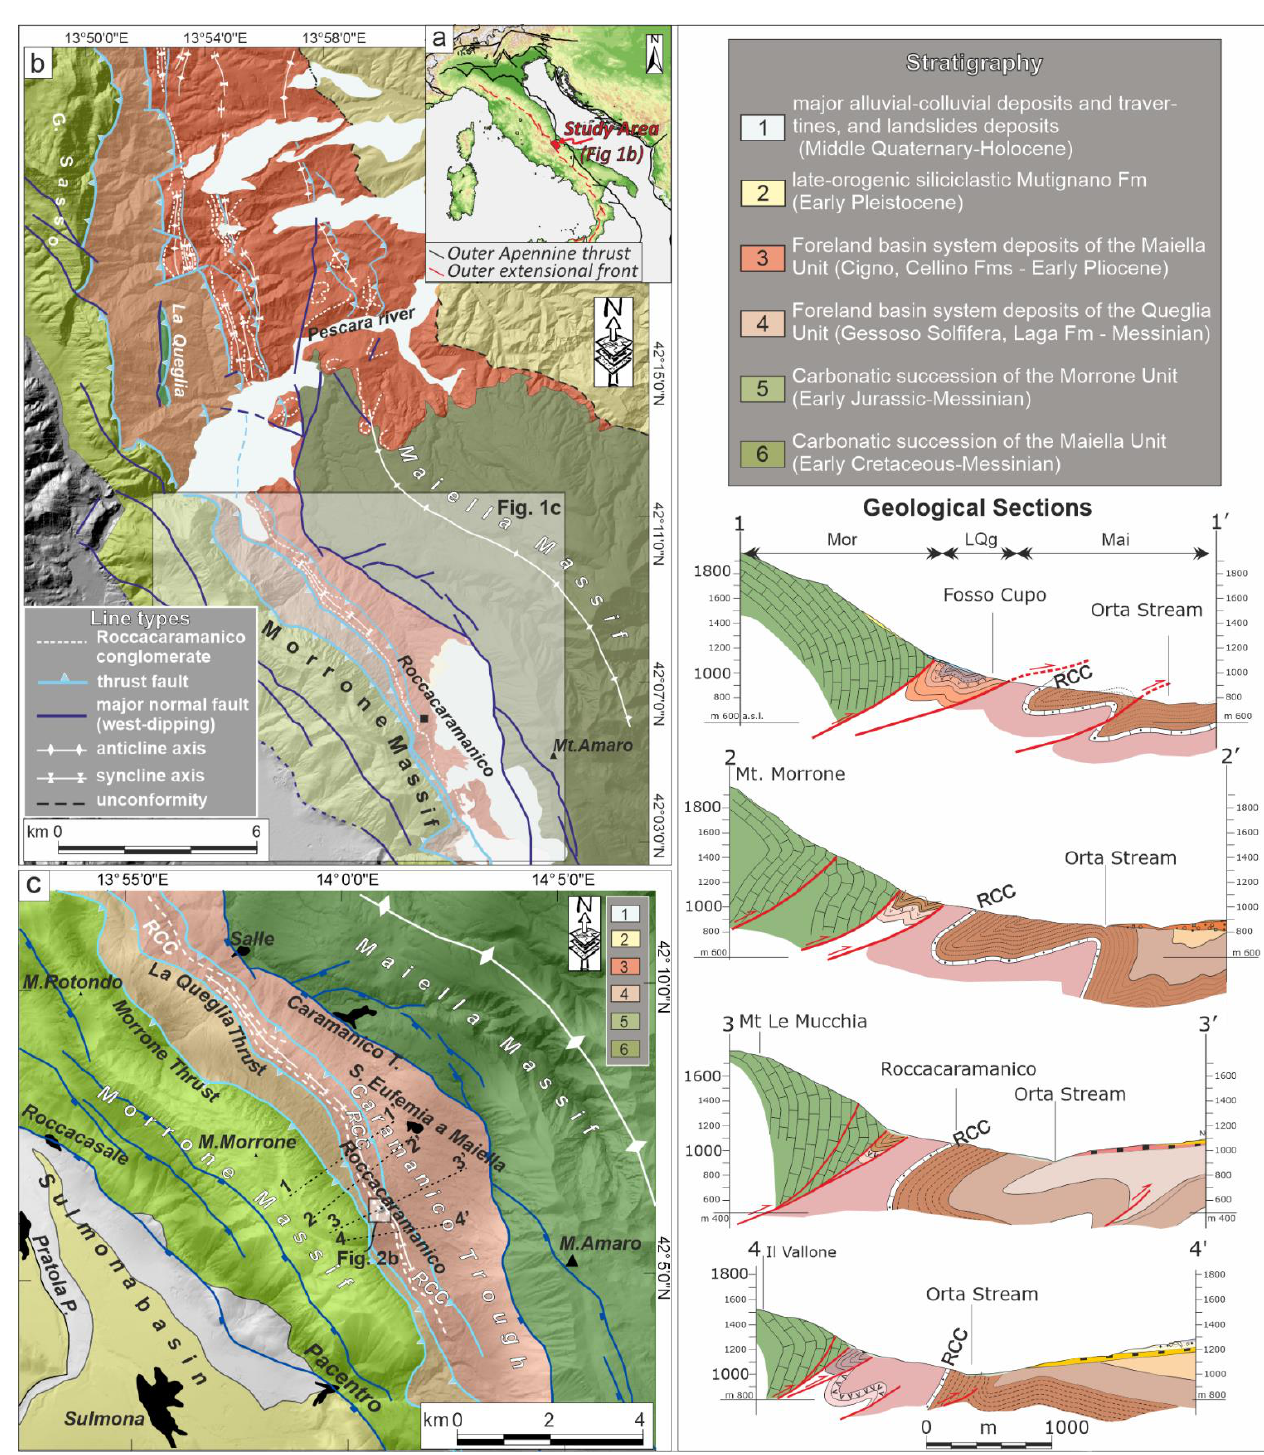
Figure 1. ( a ) Location map of the investigated region in the Italian peninsula ( b ) Structural geological scheme of the study area in the context of the eastern Abruzzo Apennines; ( c ): geological details of the Caramanico throw delimited by the Morrone and Maiella ranges. Geological cross sections 1–4 (traced in panel ( c )) show the geometry of the contractional structures close to Roccacaramanico; Mor = Morrone unit, LQg = La Queglia unit, Mai = Maiella unit.